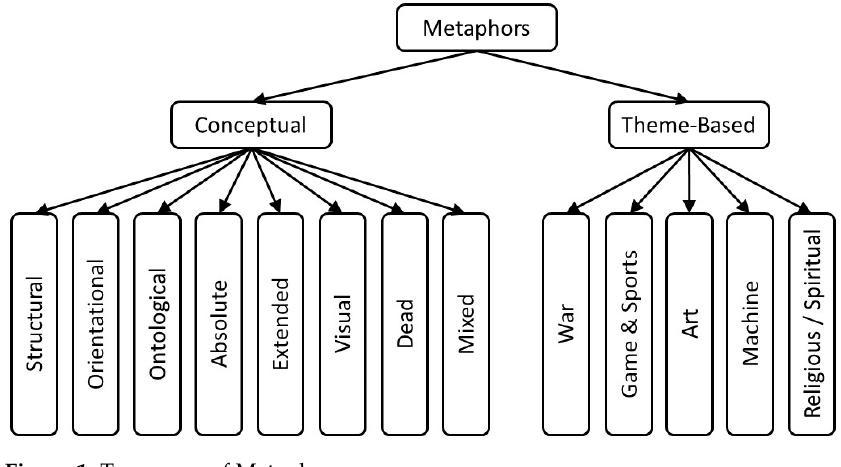
Figure 1. Taxonomy of Metaphors.